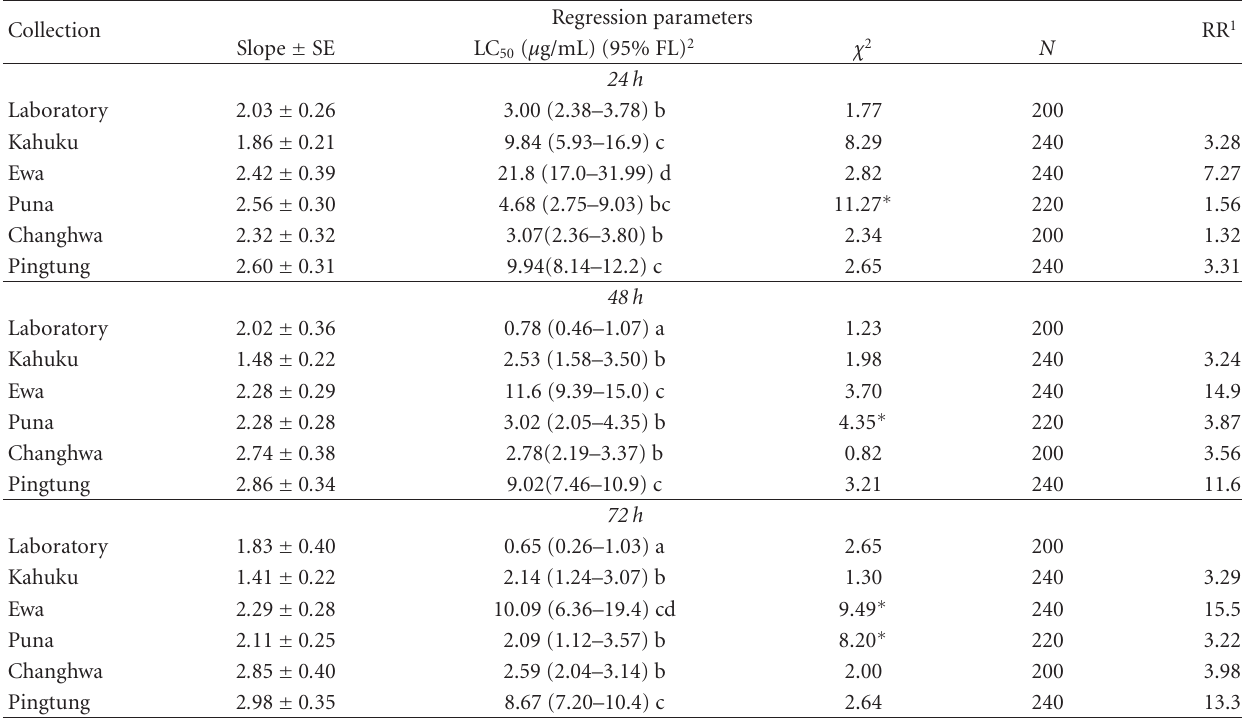
Table 4: Susceptibility and resistance to spinosad by feeding application in Bactrocera cucurbitae flies (collected during August 2008 in Hawaii and from July to September 2007 in Taiwan) from wild populations and laboratory strains after 24, 48, and 72 h.